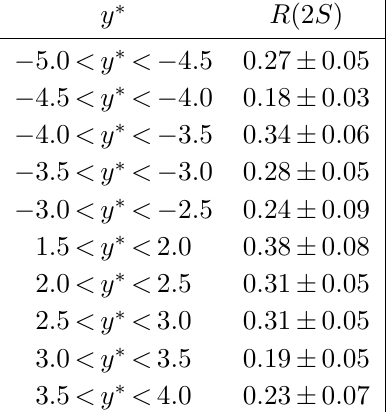
Table 19 . (cid:7) (2 S ) to (cid:7) (1 S ) ratio, R ( (cid:7) (2 S )), in p Pb and Pb p as a function of y (cid:3) integrated over p T in the range 0 < p T < 25 GeV =c